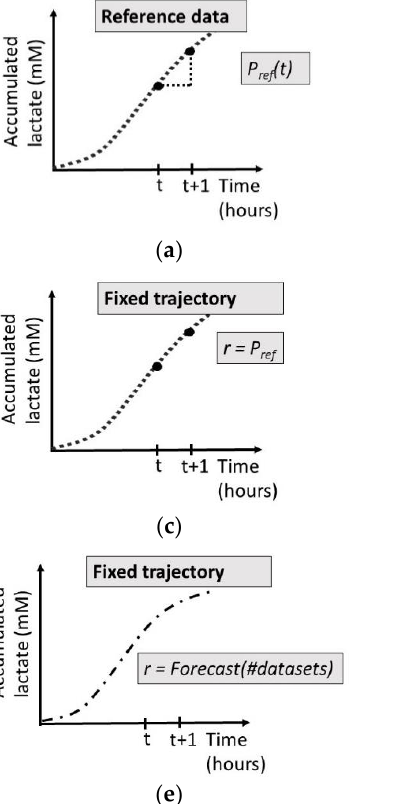
Figure 2. ( a ) Reference experimental data, ( b ) ongoing controller experimental data, ( c ) fixed target function, defined as the accumulated lactate values generated during one reference experiment, ( d ) adaptive target function, starting after 48 h, combining the measured accumulated lactate value of the ongoing controller experiment at time t together with the increase in accumulated lactate values of the reference experiment between time t and t + 1, ( e ) fixed target function, defined by a forecast of the accumulated lactate based on multiple previously gathered